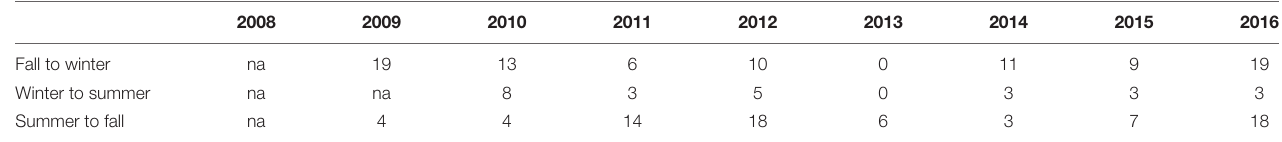
Frontiers in Marine Science |